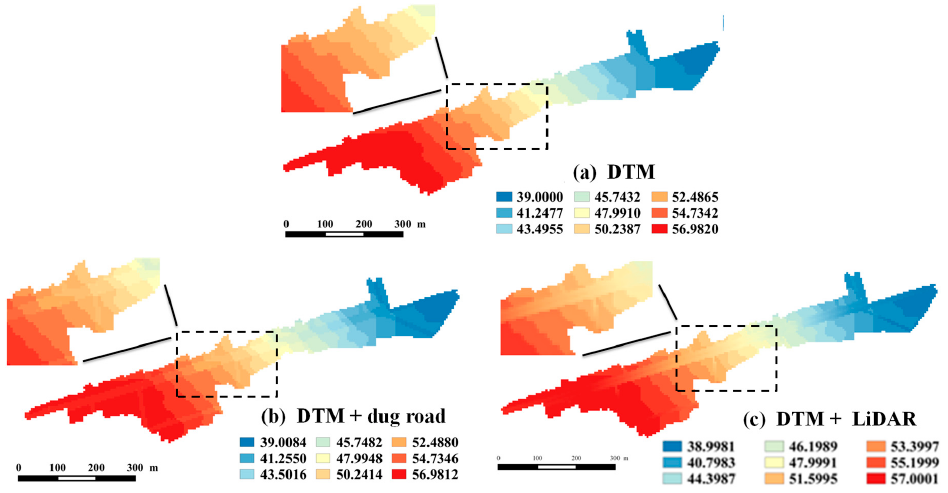
Figure 4. Three different topographic input data. For ( a ) DTM, ( b ) DTM—dug road, and ( c ) DTM +